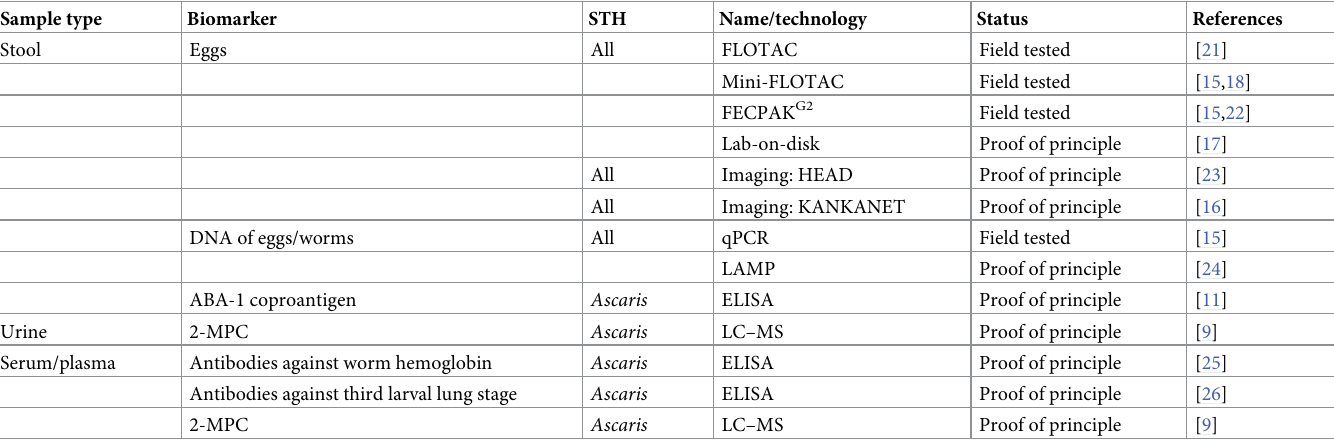
Table 1. An overview of the technologies or biomarkers that have been evaluated for human STH. Sample